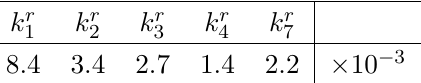
Table 1 . Numerical values of the n f = 2 EM LECs k r their relation to K r . To the k r it is assigned a conservative 100% i i